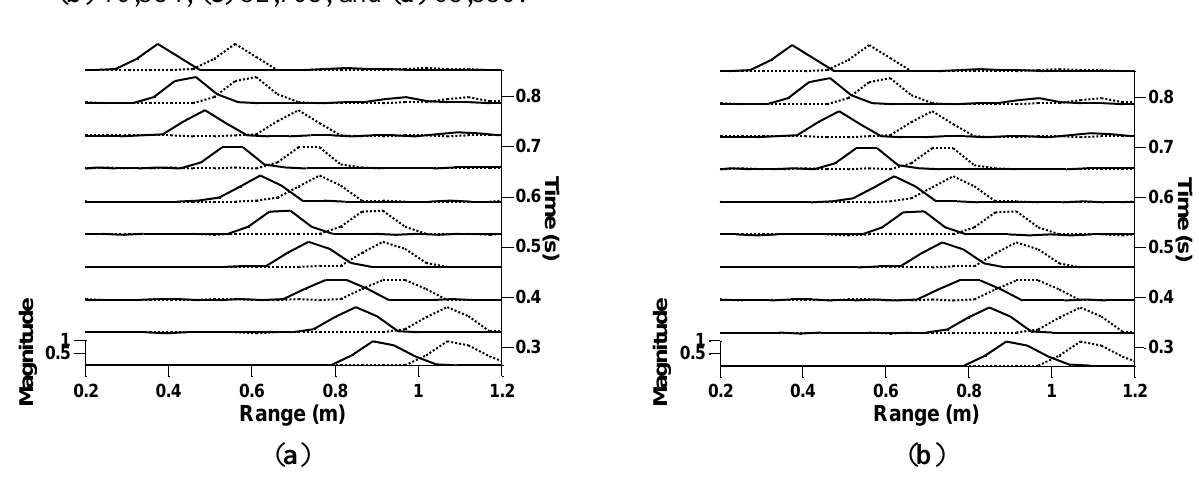
Figure 13. Results of range profile correction using different frame sizes: ( a )